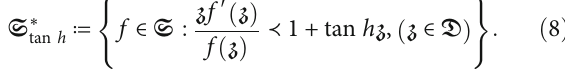
ffiffiffiffiffiffiffiffiffiffi 1 + z